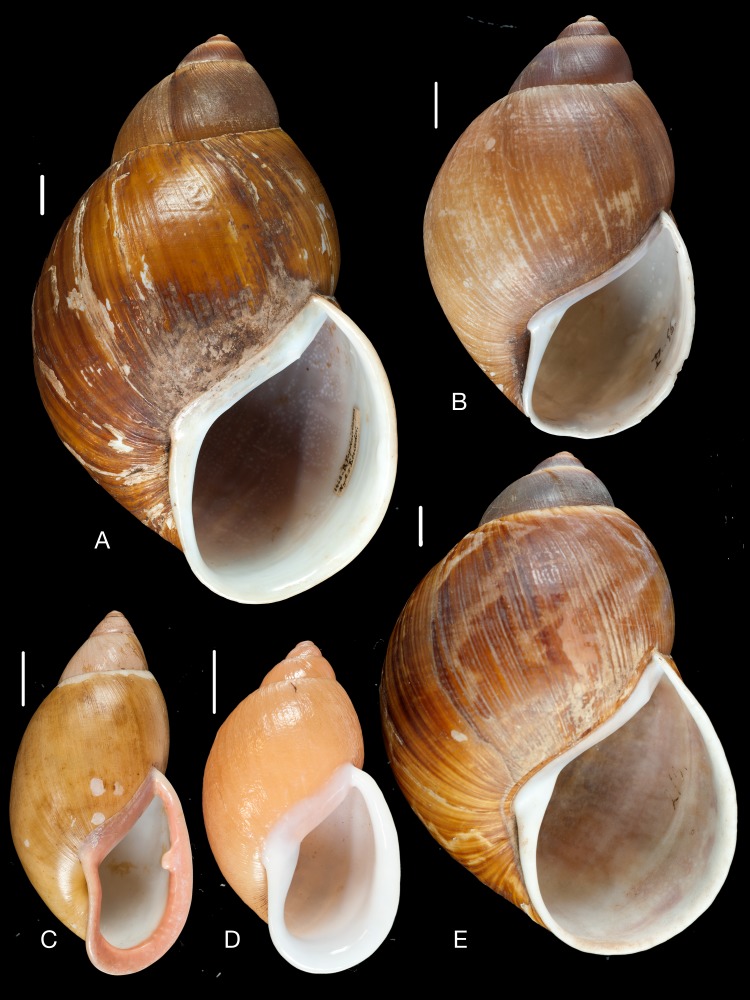
Material collected by the CCP.(A–E) Strophocheilidae. Megalobulimus popelairianus (Nyst, 1845), MNCN 15.05/48045, (A) ventral view; Megalobulimus terrestris (Spix in Wagner, 1827), MNCN 15.05/36940, (B) ventral view; Mirinaba planidens (Michelin, 1831), MNCN 15.05/13284, (C) ventral view; Strophocheilus pudicus (Müller, 1774), MNCN 15.05/13283, (D) ventral view; Megalobulimus valenciennesii (Pfeiffer, 1842), MNCN 15.05/7487, (E) ventral view. Scale line 1 cm.